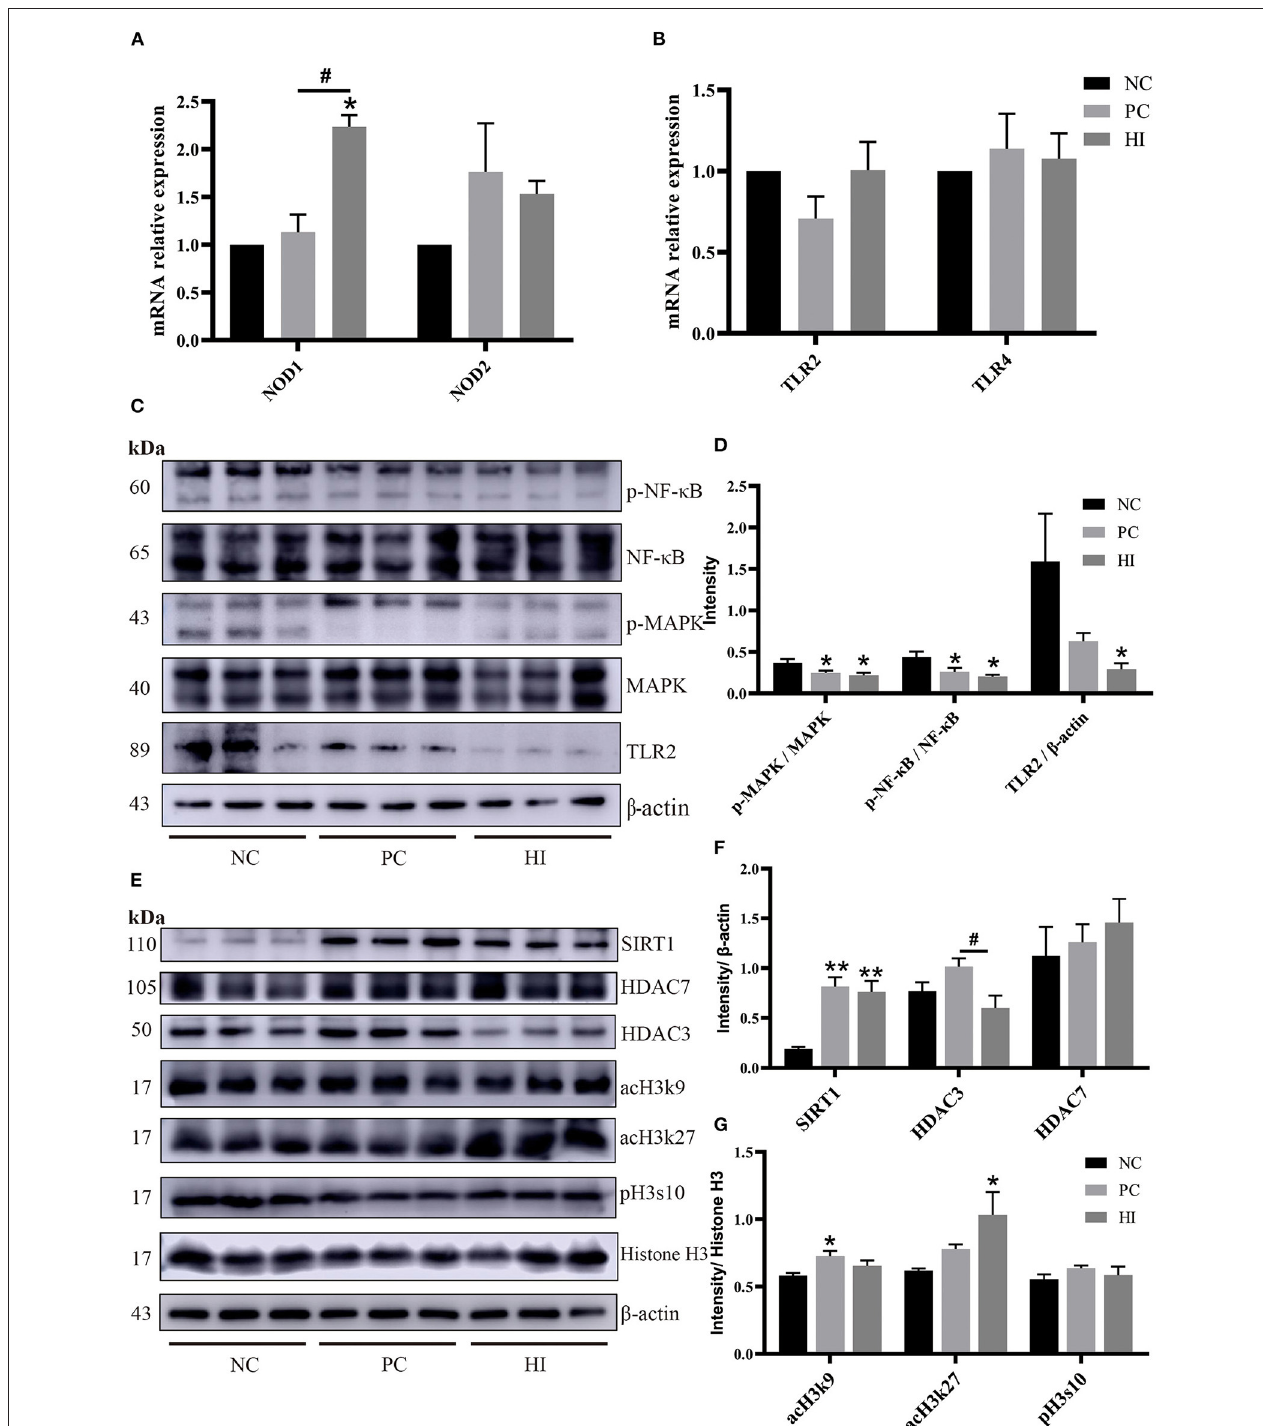
FIGURE 4 | Effect of dietary Hermetia illucens larvae on TLR2-NF- κ B/MAPK signaling pathway and histone acetylation modification in weaned pigs. Real-time quantitative PCR was performed to determine the relative mRNA expression levels of NOD1 , NOD2 (A) , TLR2 , and TLR4 (B) in the jejunum and ileum. (C) Relative protein expression levels of p-NF κ B, NF κ B, p-MAPK, MAPK, TLR2, and β -actin in the ileum were determined using western blot. (D) Statistical analysis of the data in (C) . (E) Western blotting was performed to determine the relative protein expression levels of SIRT1, HDAC7, HDAC3, acH3k9, acH3k27, histone H3, β -actin, and phosphorylation of histone H3 at serine S10 (pH3s10) in the ileum. (F,G) Statistical analysis of the data in (E). All data are expressed as the mean ± SEM (protein expression data n = 3, other data n = 6). * p < 0.05, ** p < 0.01 compared with NC, # p < 0.05 HI compared with PC.